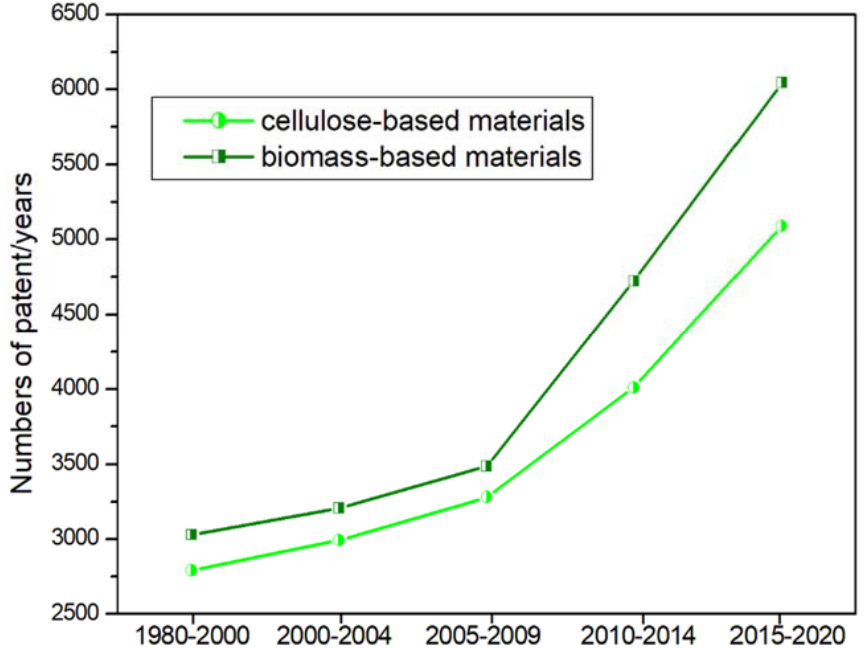
Figure 11. Time evolution of the patents deals with bio-based materials in AD.